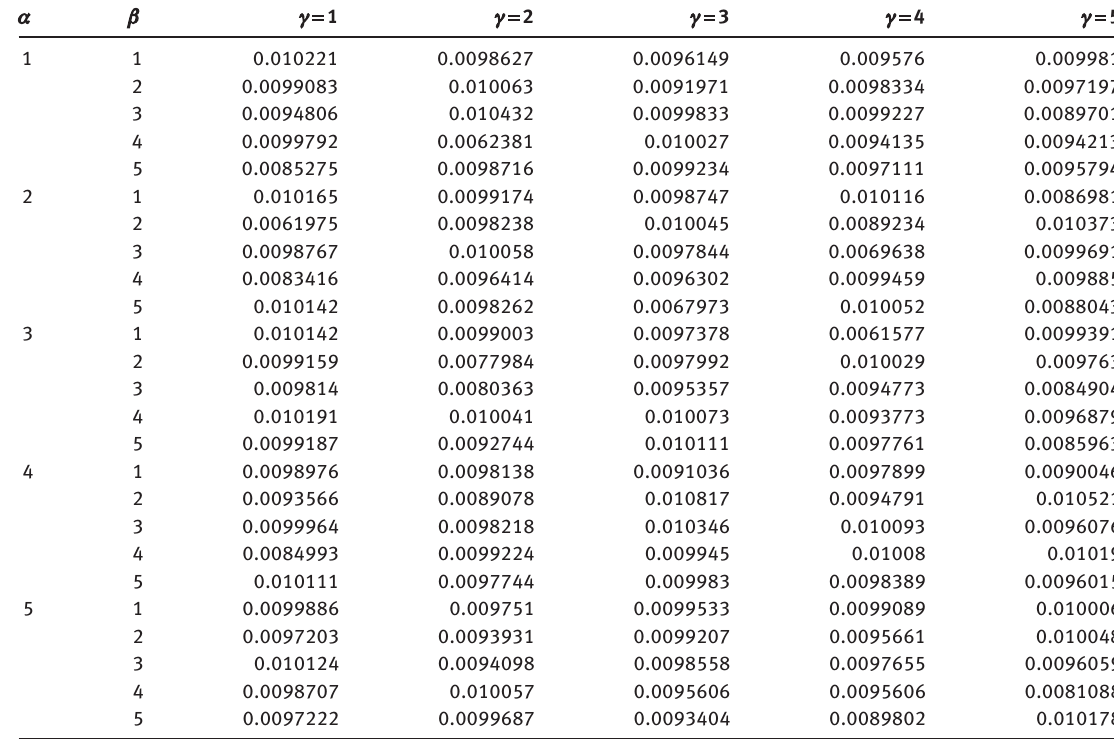
Table 3: Parameters used in Steam Pressure under Varying β and γ with the Reference of α